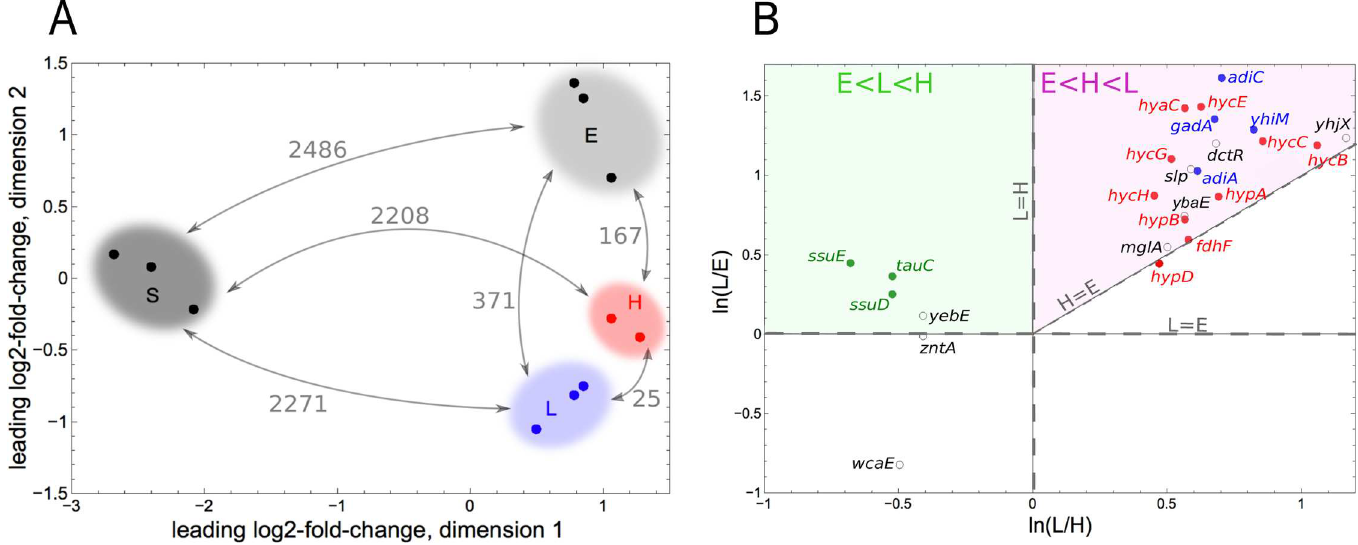
Fig 7. Biofilms under distinct fluid flow regimes exhibit exquisitely different gene expression. (A) Principalcomponentanalysisand clusteringof genesdifferentiallyexpressedin cells grown under different conditions:L (lower shear stress and lower confinement regime, i.e. 1 mm-height channel),H (highershear stress and higherconfinement, i.e. 250 μ m-heightchannel), E (planktoniccells in exponential phase), S (planktonic cells in stationary phase). The numberof genes with a False DiscoveryRate < 0.01 in our differentialexpressionanalysis,is indicatedabovearrows. (B) 3-component plot representing ln(L/E) vs. ln(L/H) where L, E and H designate mean expressionlevel in samples L, E and H respectively.Each point correspondsto a gene. Red: genes related to anaerobicmetabolism; blue: genesrelated to acid resistance; green: genes related to sulfate metabolism; black: others genes. All red and blue genes(except hypD ) fall in the purplezone: they have a lower expressionin samples E and a higherexpressionin samplesL, expressionin samples H being intermediate.